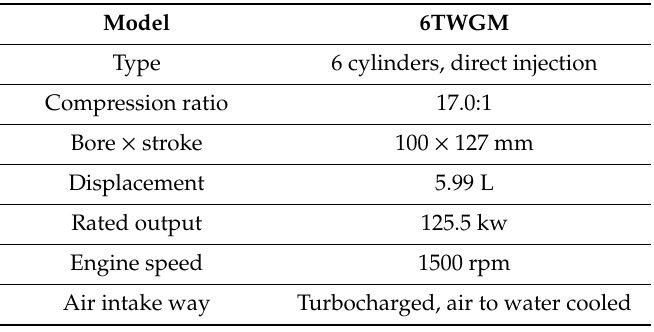
Table 1. Technical data of the engine.